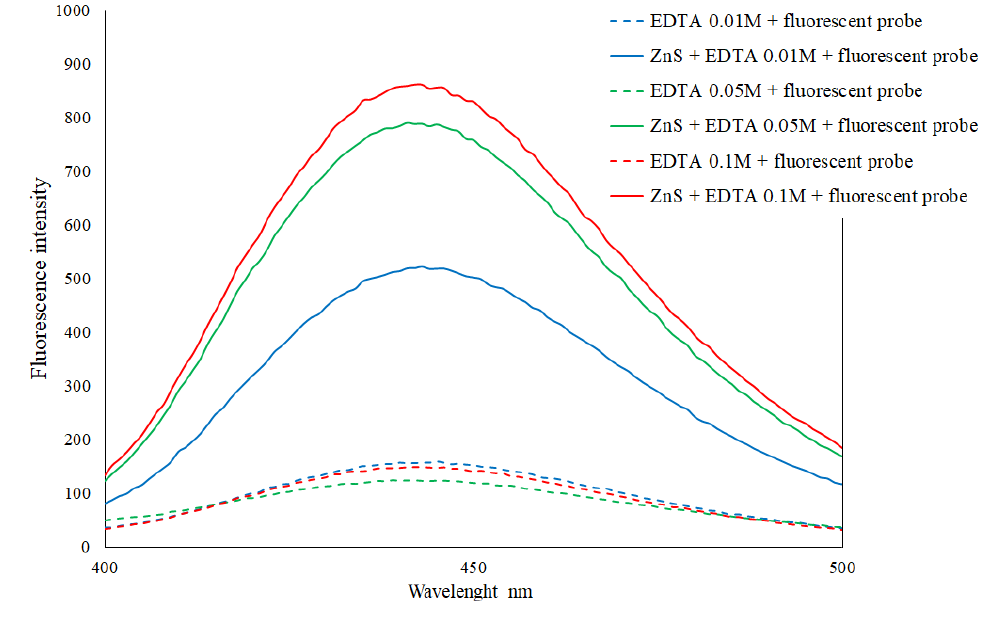
Figure 5. Fluorescence spectra. Fermentation 2021 , 7 , x FOR PEER REVIEW